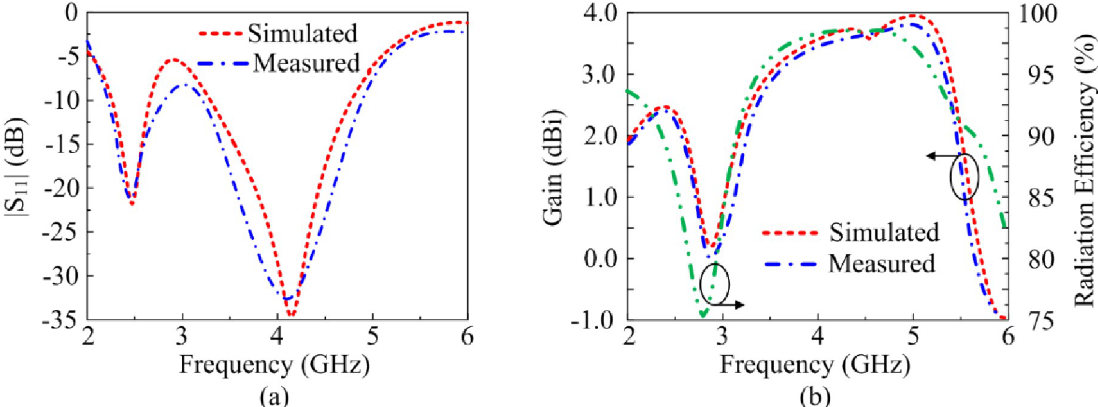
Fig 7. The reflection-coefficient, gain and radiation efficiency response of the proposed antenna when PIN diode D1 is reverse biased and D2 is forward biased.